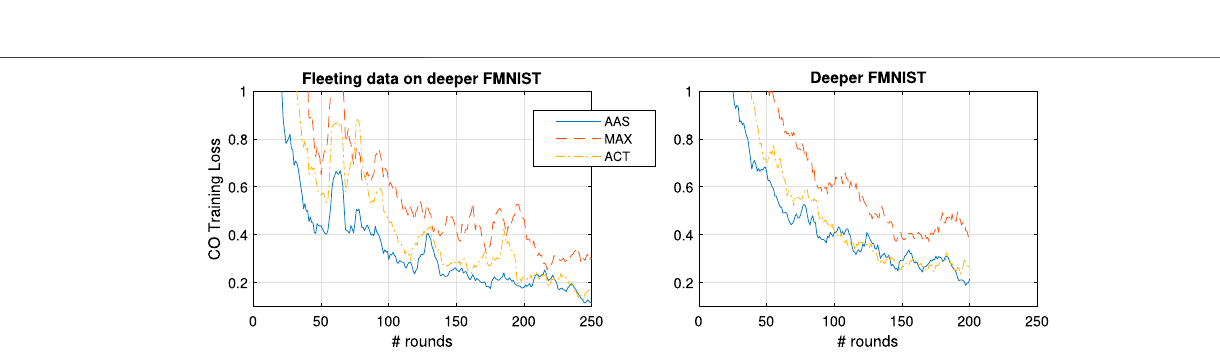
Frontiers in Communications and Networks |